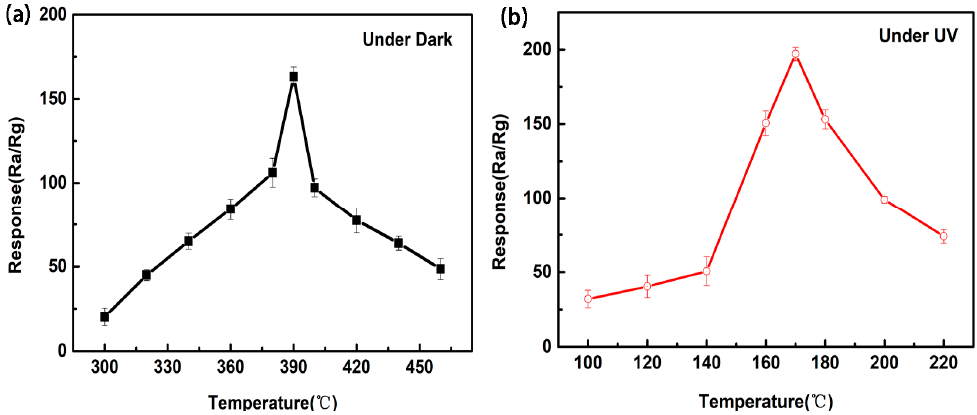
Figure 4. Response of the ZnO film sensor to 1000 ppm ethanol ( a ) under dark and ( b ) under UV light illumination as a function of the operating temperature.